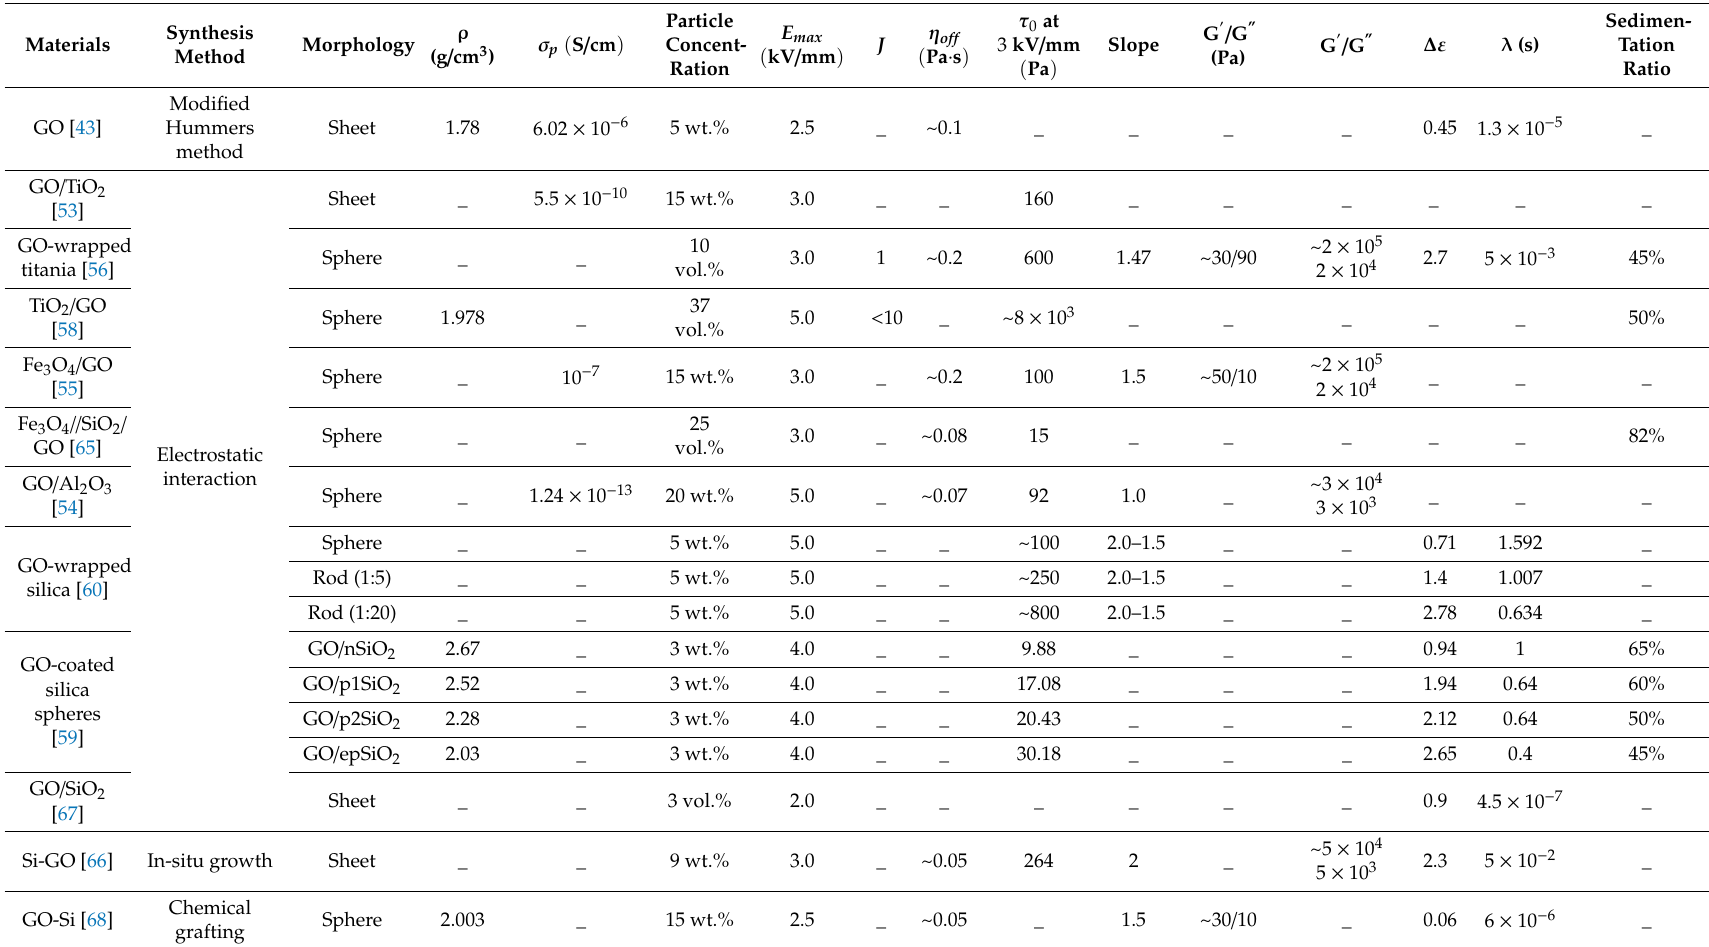
Table 1. Main information of GO-based composites applied to ER